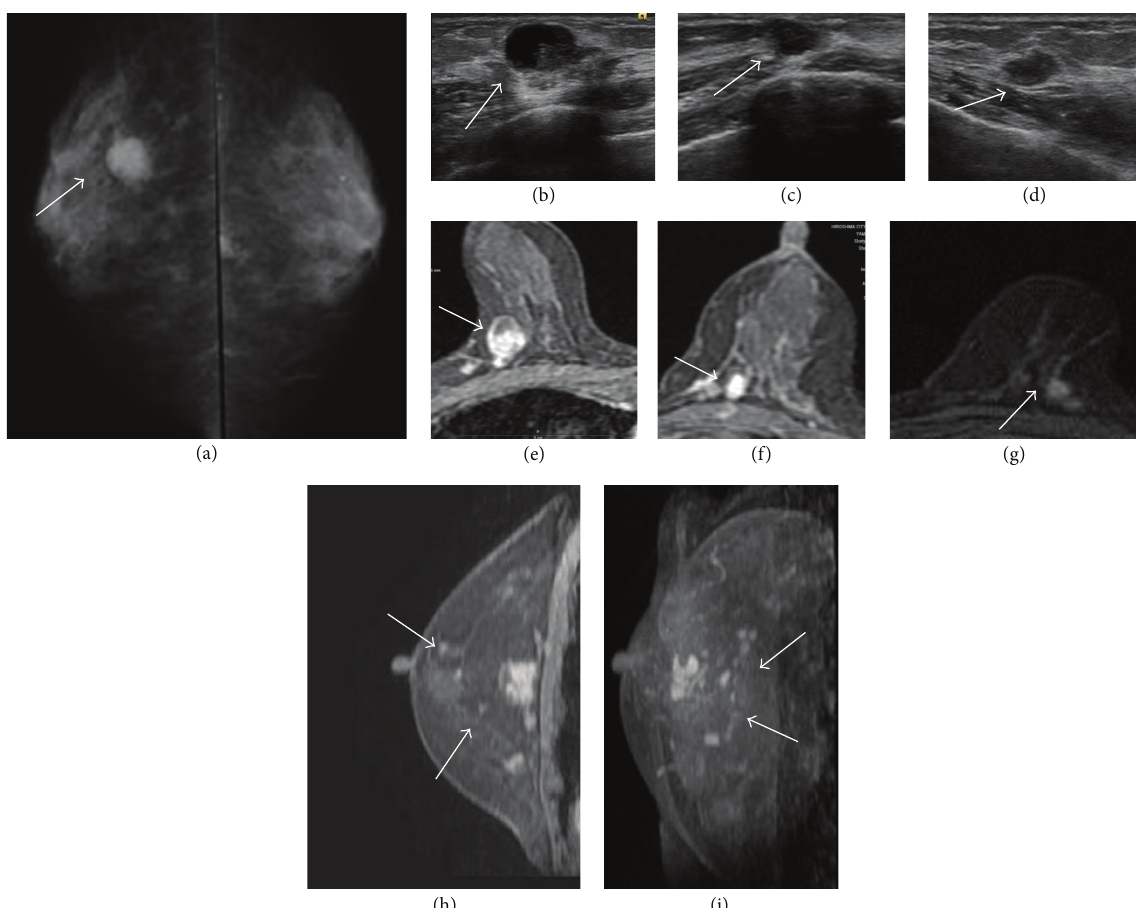
Figure 1: Mammogram showing a round, high-density mass in the right breast ((a), arrow). Ultrasound view showing tumor 1 in the right breast (b) and tumors 2 and 3 in the left breast ((c), (d), resp.; arrows). Magnetic resonance imaging (MRI) scans showing all of these tumors ((e), (f), and (g); arrows) with diffuse nodules surrounding the tumors in the bilateral breast ((h): left; (i): right;